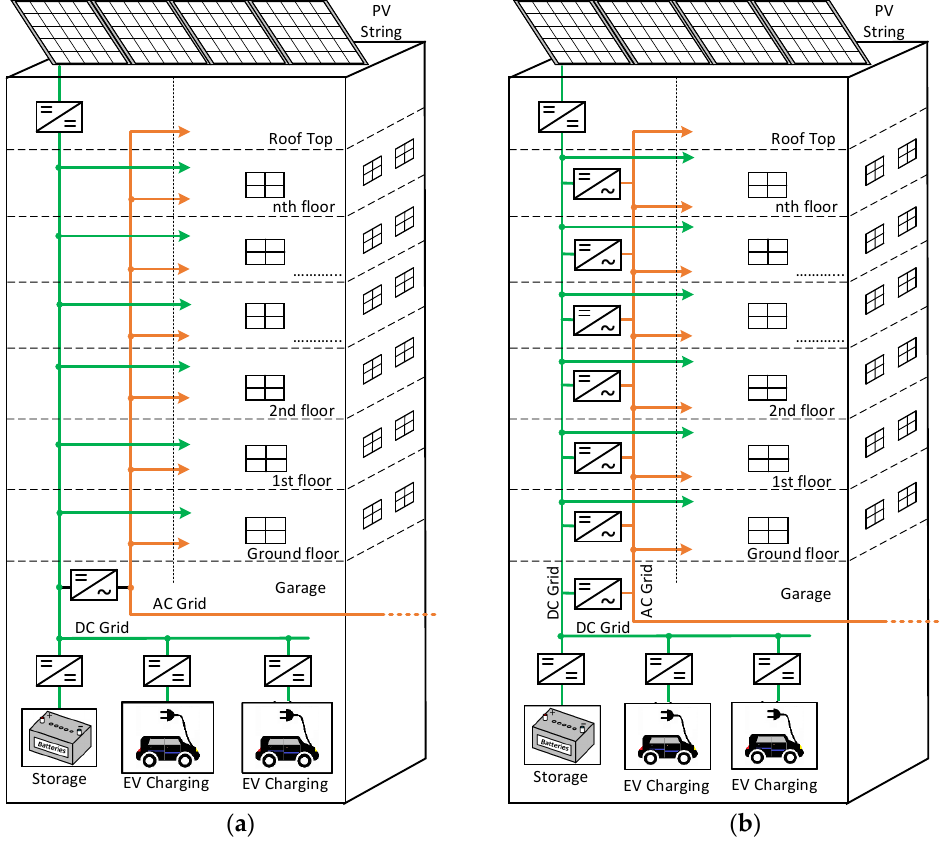
Figure 13. Possible structure of the electrical infrastructure for buildings in which it is also considered a DC infrastructure inside the residences: ( a ) only with one interconnection and ( b ) with more than one interconnection.